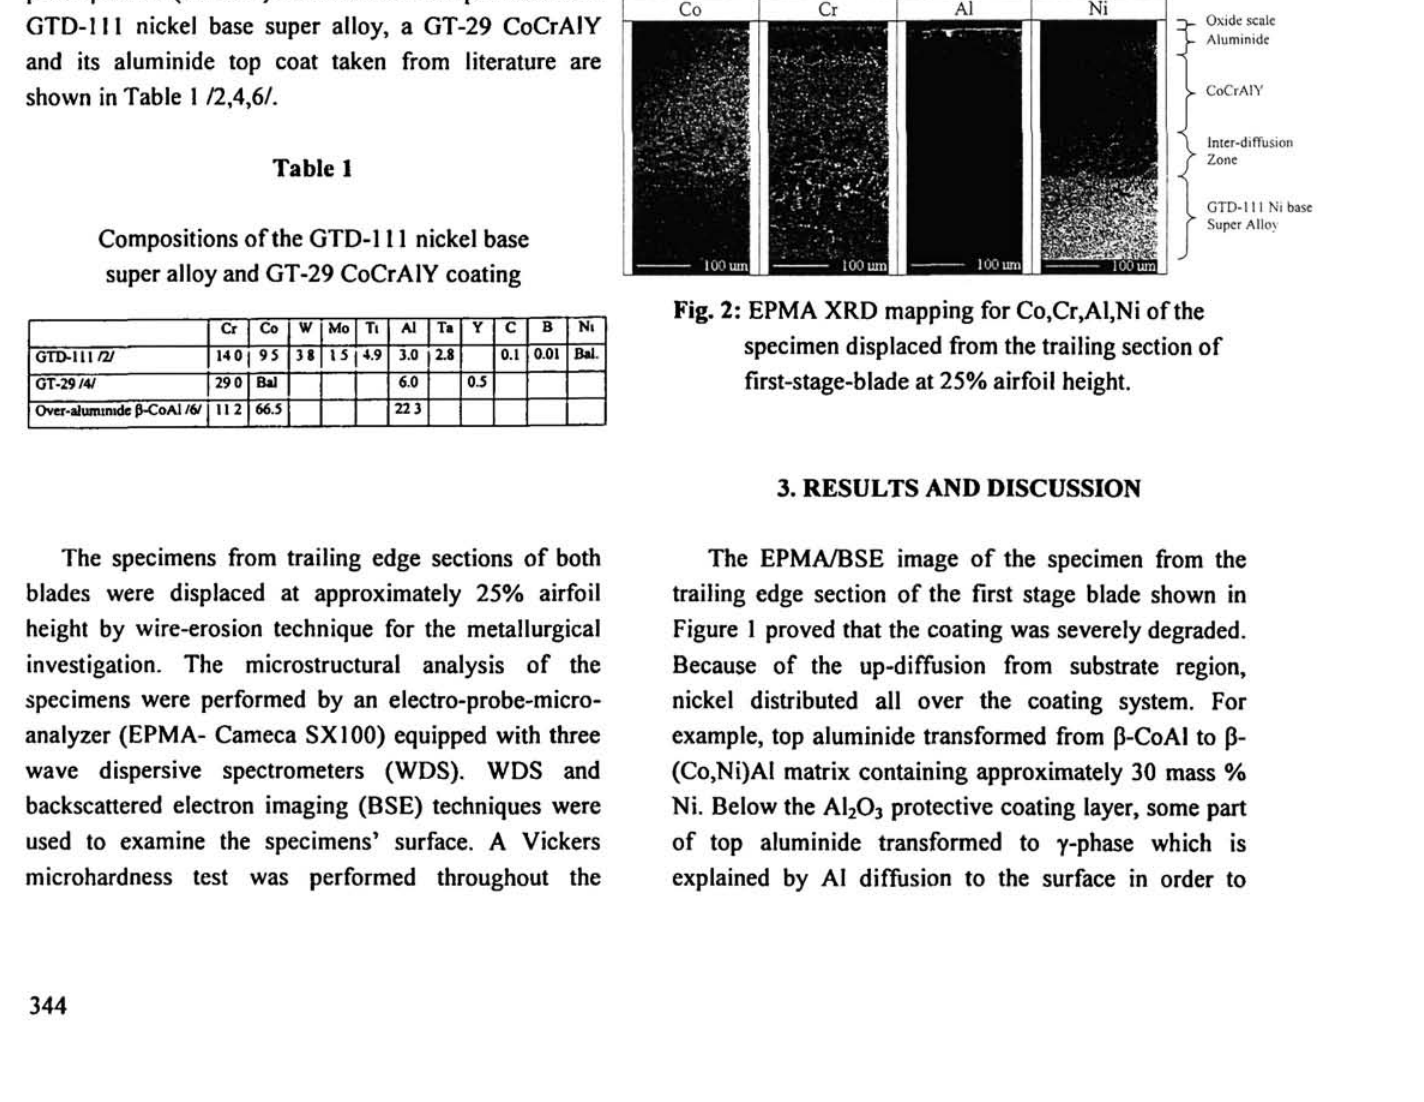
Fig. 1: The backscattered electron image (BSE) of the specimen displaced from the trailing section of first-stage-blade at 25% airfoil height.